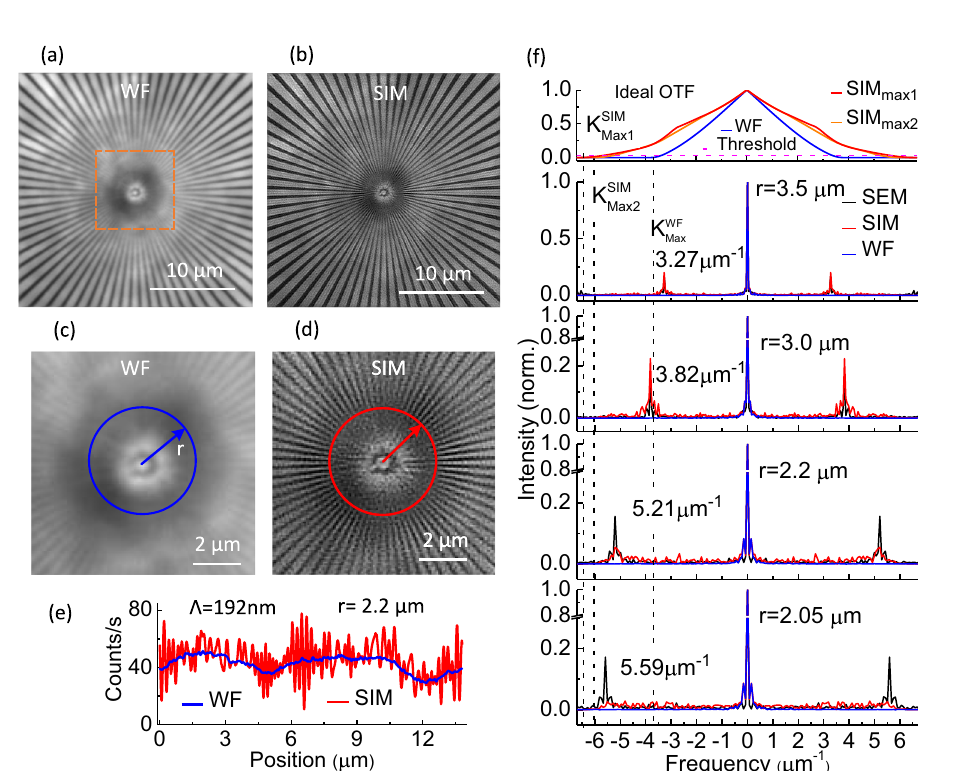
repeated fi ve times. c Optical spectra of the UV exciting beam and the fl uor- escent dyes. λ ex : excitation wavelength, λ em : emission wavelength. d to f Fluorescence images ofthe sector targetilluminated bystructuredlightforthe D D Λ D 1 , 2 , and 3 orientations, respectively. ex : modulation period of the fringe pattern.